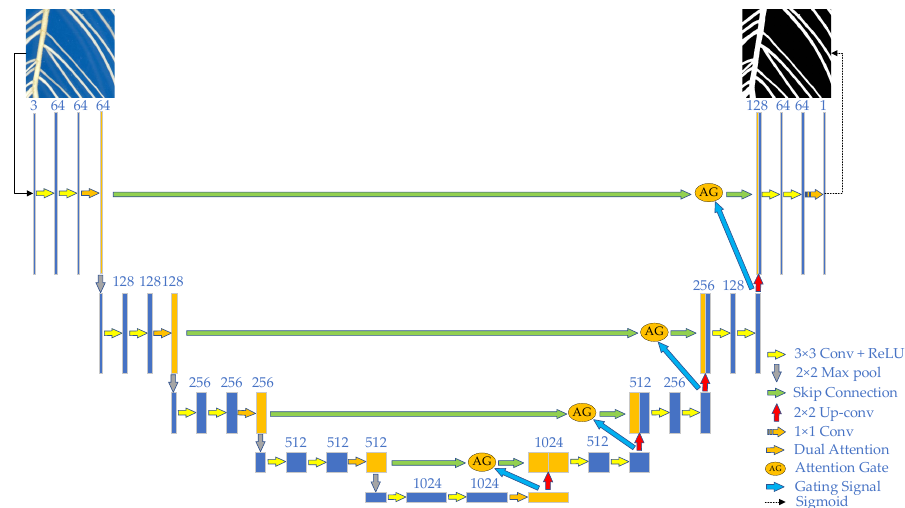
Table 2. Detailed parameters of the proposed model.